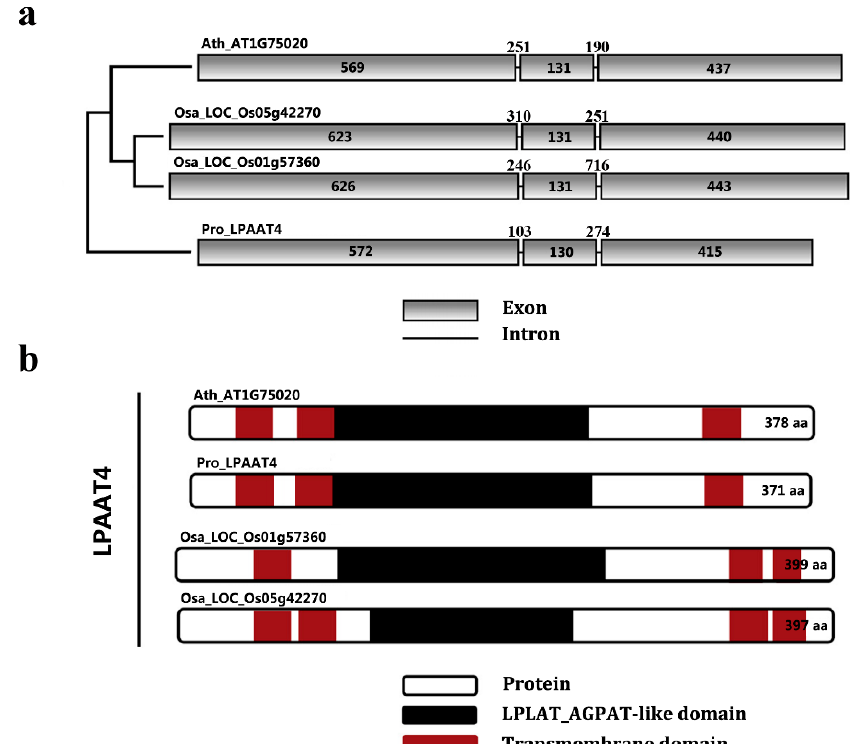
Figure 4. Comparative analysis of gene structure and conserved domain in the LPAAT4 proteins. ( a ) exon–intron structure of plant LPAAT4 genomic DNAs. Representative sequences are presented for each cluster: A. thaliana (Ath), O. sativa (Osa) and P. rockii (Pro). The size of each exon and intron is shown by bp; ( b ) prediction of the transmembrane and acyltransferase domains of plant LPAAT4 proteins. Predicted transmembrane structures ( red ) and LPLAT_AGPAT-like domain ( black ) of representative species were obtained using the transmembrane sever TMHMM-2.0 and the SMART database with the complete protein sequences. The sequences are represented as simplified boxes . The size of each sequence is shown by aa residues.